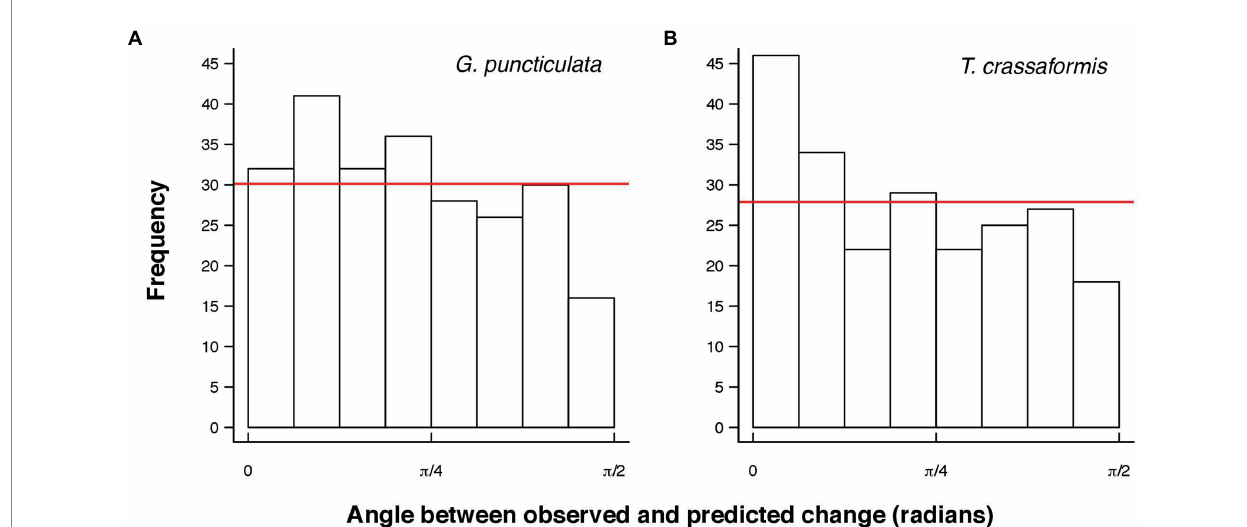
FIGURE 4 Angles between observed and predicted evolutionary change from one time slice to the next for Globoconella puncticulata (A) and Truncorotalia crassaformis (B) . Red lines indicate the expected frequency of the same number of angles drawn from a random distribution. Angles are significantly smaller than expected from a random distribution for both species (Wilcoxon rank sum test, p = 0.0037 for G. puncticulata and p = 0.00013 for T. crassaformis